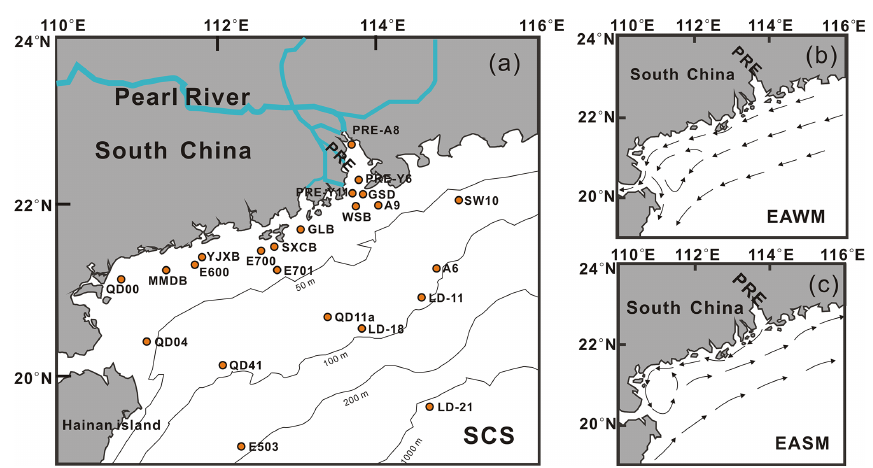
Figure 1. (a) Sampling sites and patterns of the surface coastal currents in (b) EAWM and (c) EASM seasons (modified from Liu et al.,